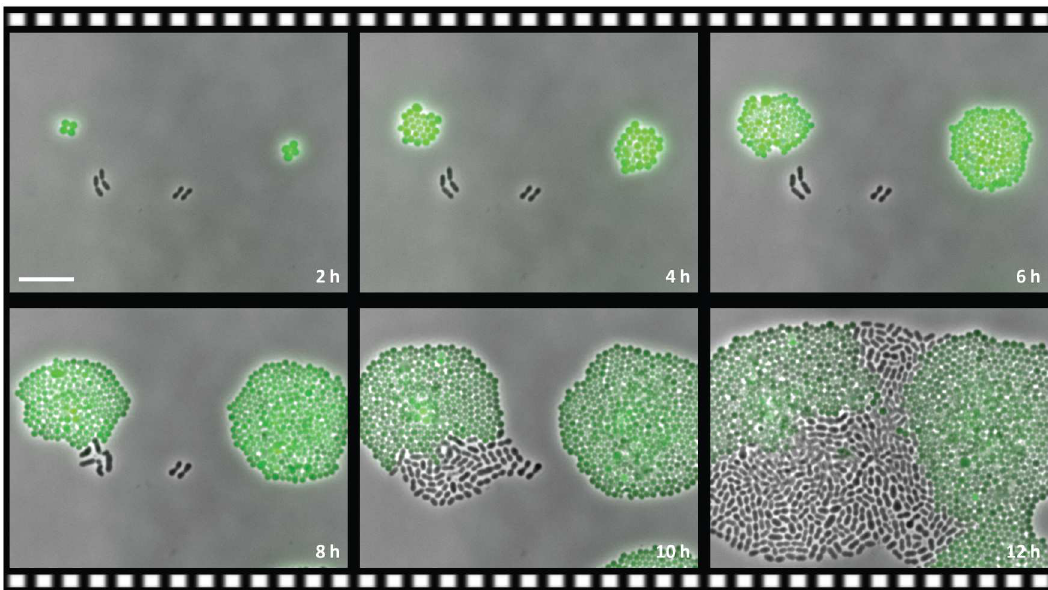
doi:10.1371/journal.pbio.2000631.g003